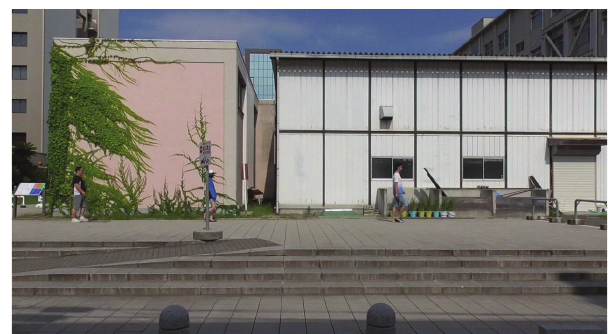
Figure 5: Location 1.